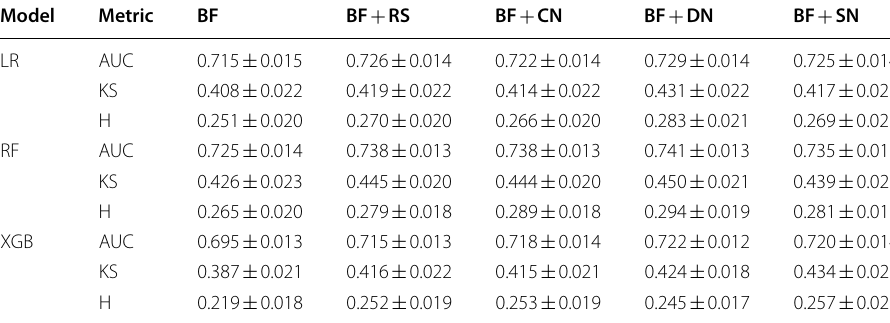
Each metric is measured in mean of 100 estimates obtained by repeating the outer ten-fold cross-validation procedure ten times (mean standard deviation from a 95% confidence interval) ± Table 27 Discrimination performance of different feature sets under 95% confidence intervals